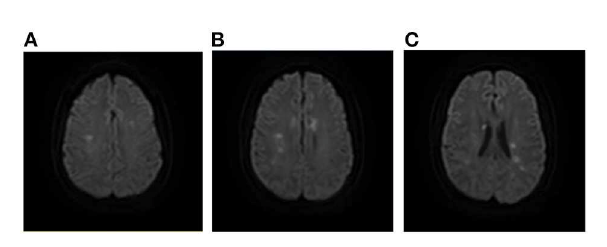
FIGURE8 A case of AMIMCT caused by systemic hypo-perfusion. A 37-year-old man had developed severe hypertension and huge fluctuation of blood pressure, which led to multiple stroke. Infarcts were located mainly at the bilateral internal border zones (A–C) . AMIMCT, acute multiple infarcts in multiple cerebral territories.